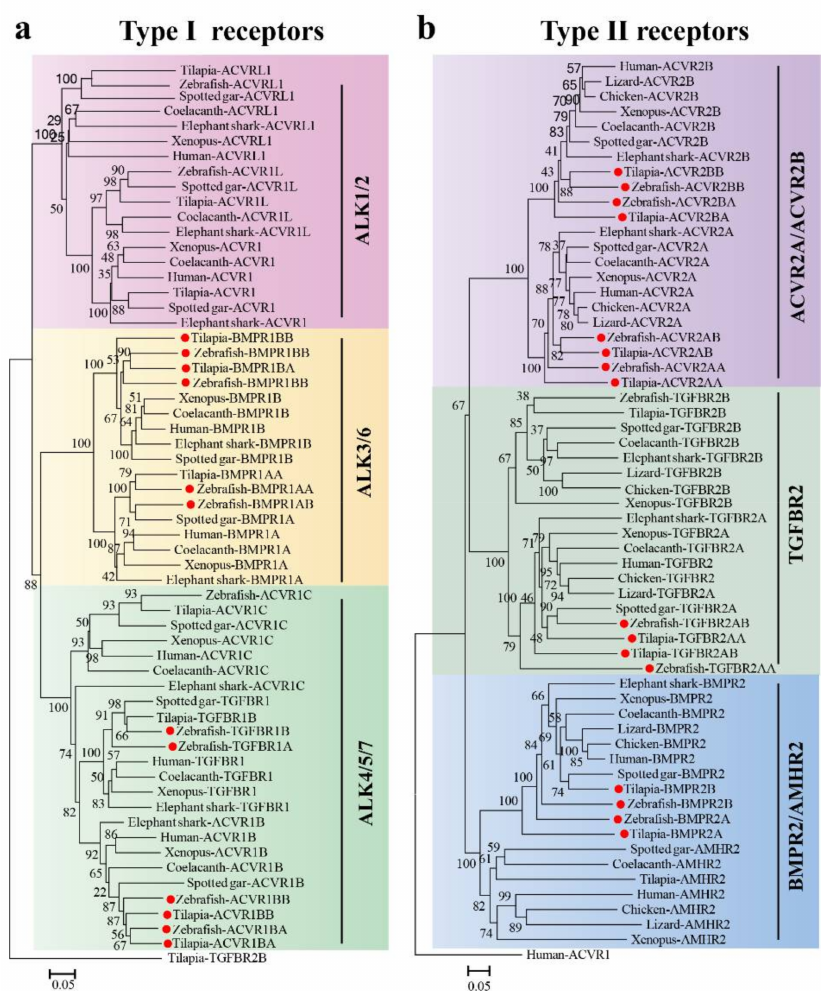
Figure 3. Phylogenetic trees of TGF- β type I ( a ) and type II ( b ) receptors. The trees were constructed using the same method as described in Figure 2. ( a ) Type I receptors from elephant shark, coelacanth, spotted gar, xenopus, human, zebrafish and tilapia were clustered into ALK1/2, ALK3/6 and ALK4/5/7 three branches, tilapia TGFBR2B was used as an outgroup; ( b ) Type II receptors from elephant shark, coelacanth, spotted gar, xenopus, lizard, chicken, human, zebrafish and tilapia were clustered into ACVR2A/ACVR2B, TGFBR2 and BMPR2/AMHR2 three branches, human ACVR1 was used as an outgroup. Red dots indicate genes which retained two copies in teleosts after 3R events. GenBank accession numbers of the sequences used are listed in Table